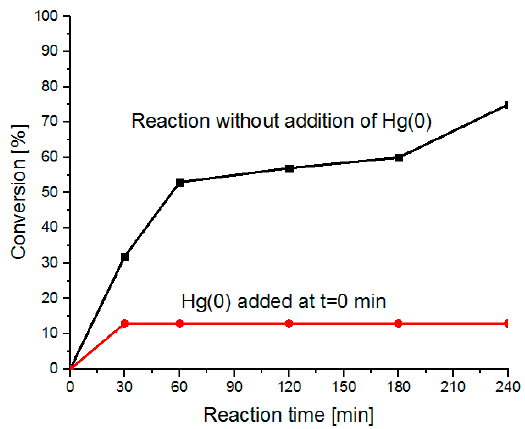
Figure 13. Suzuki–Miyaura reaction of 2-bromotoluene in the presence of Hg(0).